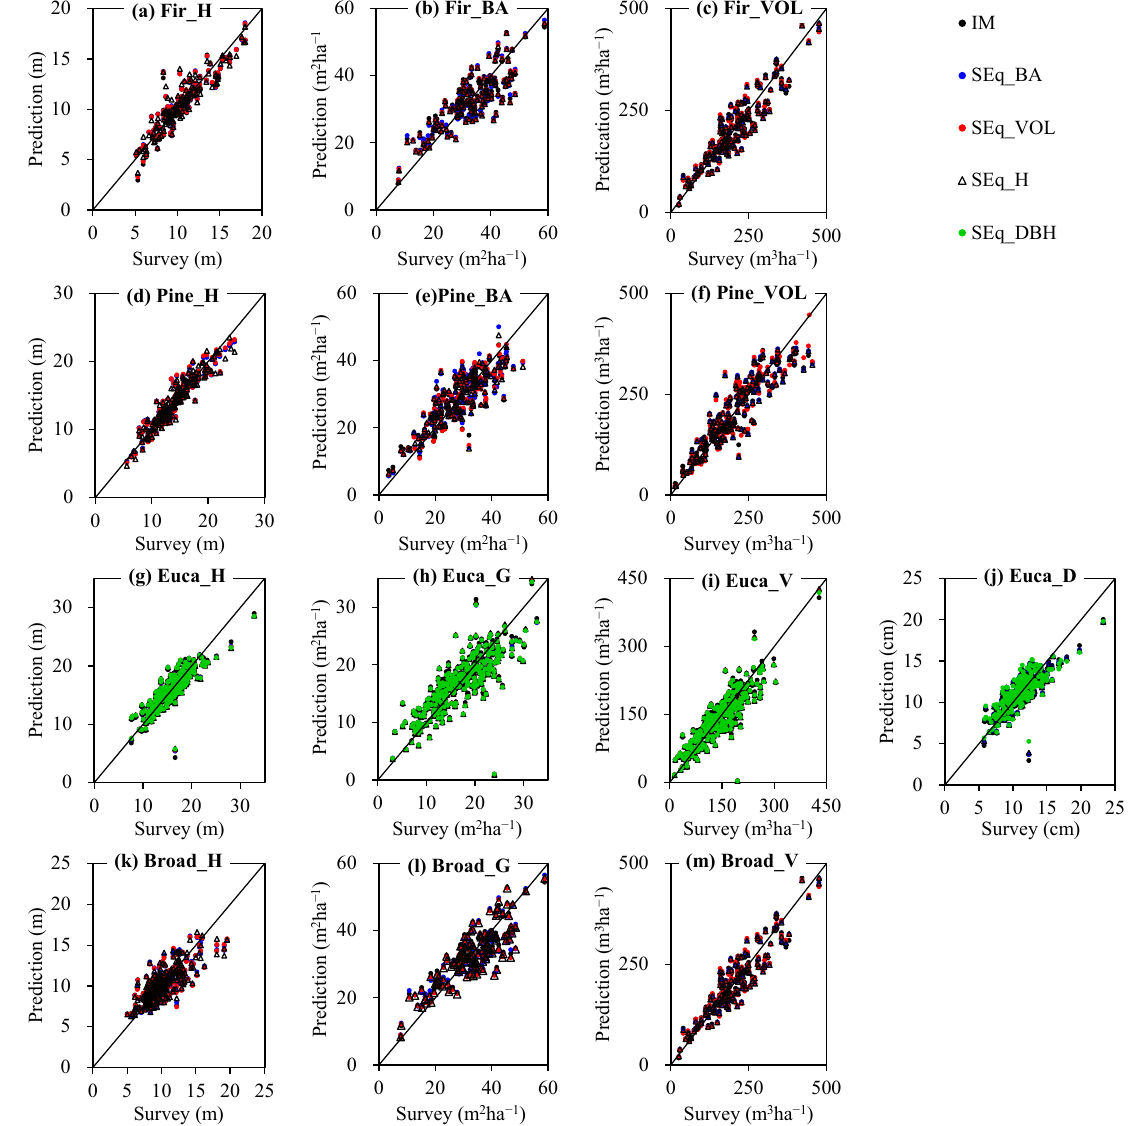
Figure 4. Scatterplots of measured forest attributes vs. LiDAR-predicted forest attributes obtained from simultaneous equations and independence models (the solid line is the 1:1 line) of four forest types: ( a – c ) fir forests; ( d – f ) pine forests; ( g – j ) eucalyptus forests; ( k – m ) broad-leaved forests.